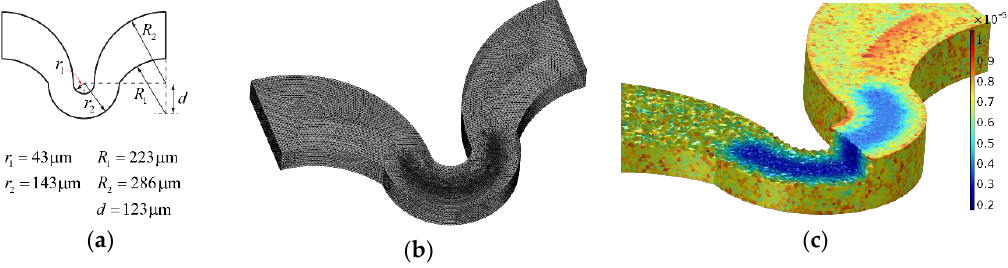
Figure 2. ( a ) Geometry’s dimensions of the serpentine; ( b ) meshed simulation domain for the CFD simulation represented as a periodic unit of the serpentine. The channel is 73 μm in height; ( c ) inner region of the simulation domain. Part of the mesh has been removed to expose the insides of the mesh, emphasizing the effects of the finer mesh regions in the small curve. Color scale (μm) represents the mesh element size.